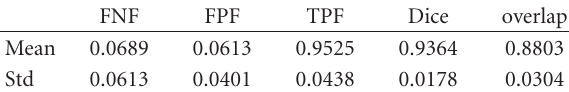
Table 1: Quantitative validation